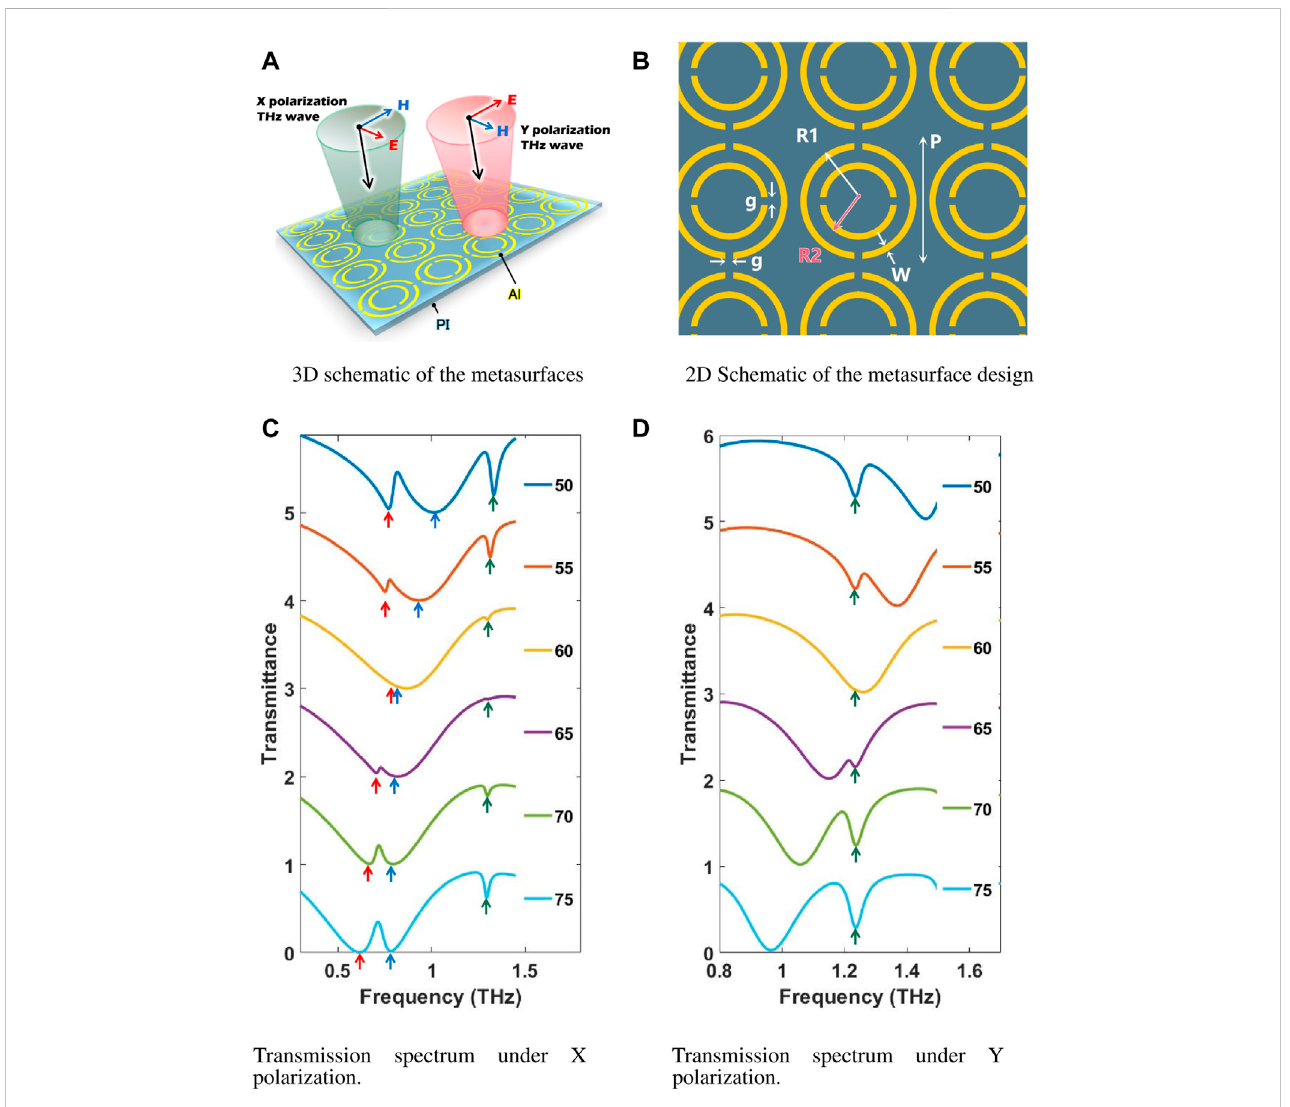
FIGURE 1 Model design and transmission spectrum measurement. (A) 3D sketch map of the metasurface. (B) Plan sketch of design metasurface. The design dimensionsare p =200 um,R1=90 um,W=10 um,g=12 um,andR2changes. (C) Amplitudetransmission spectraoftheelementarysurfaceswithdifferent R2underXpolarization. (D) AmplitudetransmissionspectraofmetasurfaceswithdifferentR2underYpolarization.Theredarrowandthebluearrowmarkthe two different eigenfrequency corresponding to FW-BIC, and the green arrow mark the two same eigenfrequency corresponding to